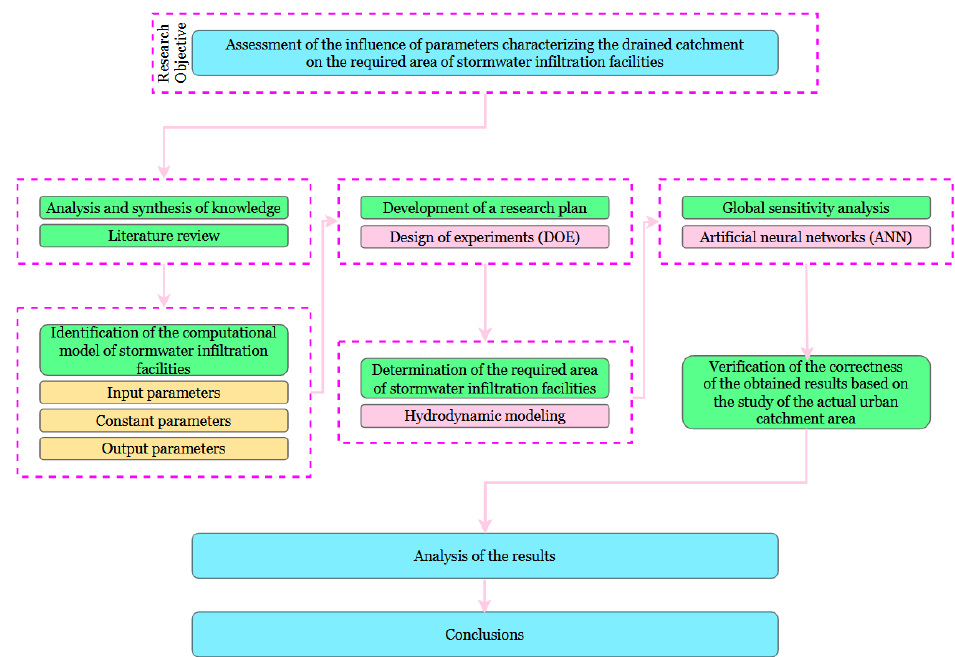
Figure 1. Research plan.